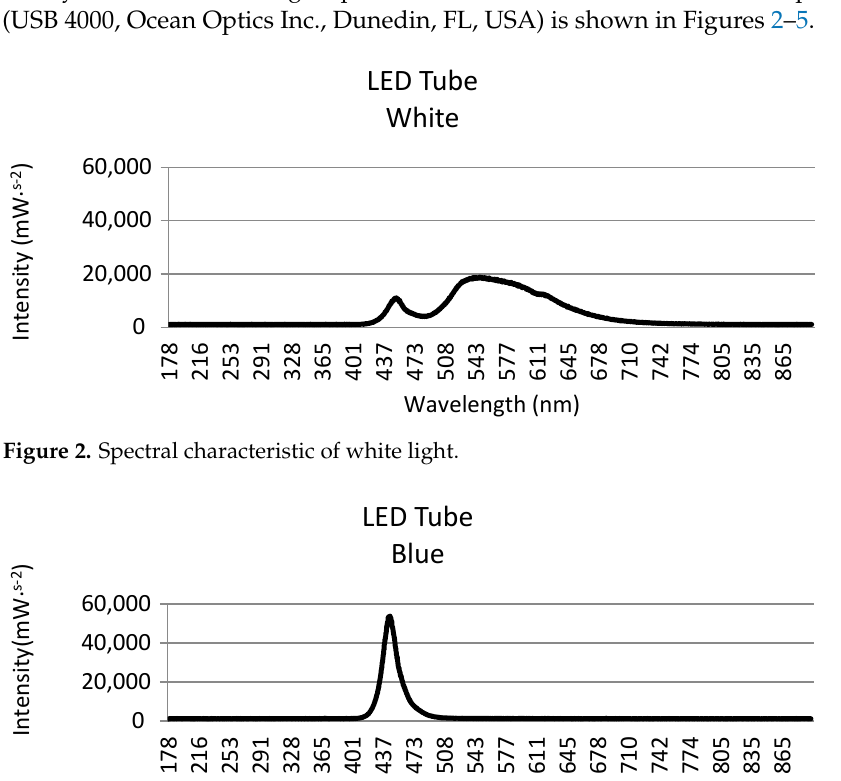
Figure 1. Three-layer shelf system in growth room.